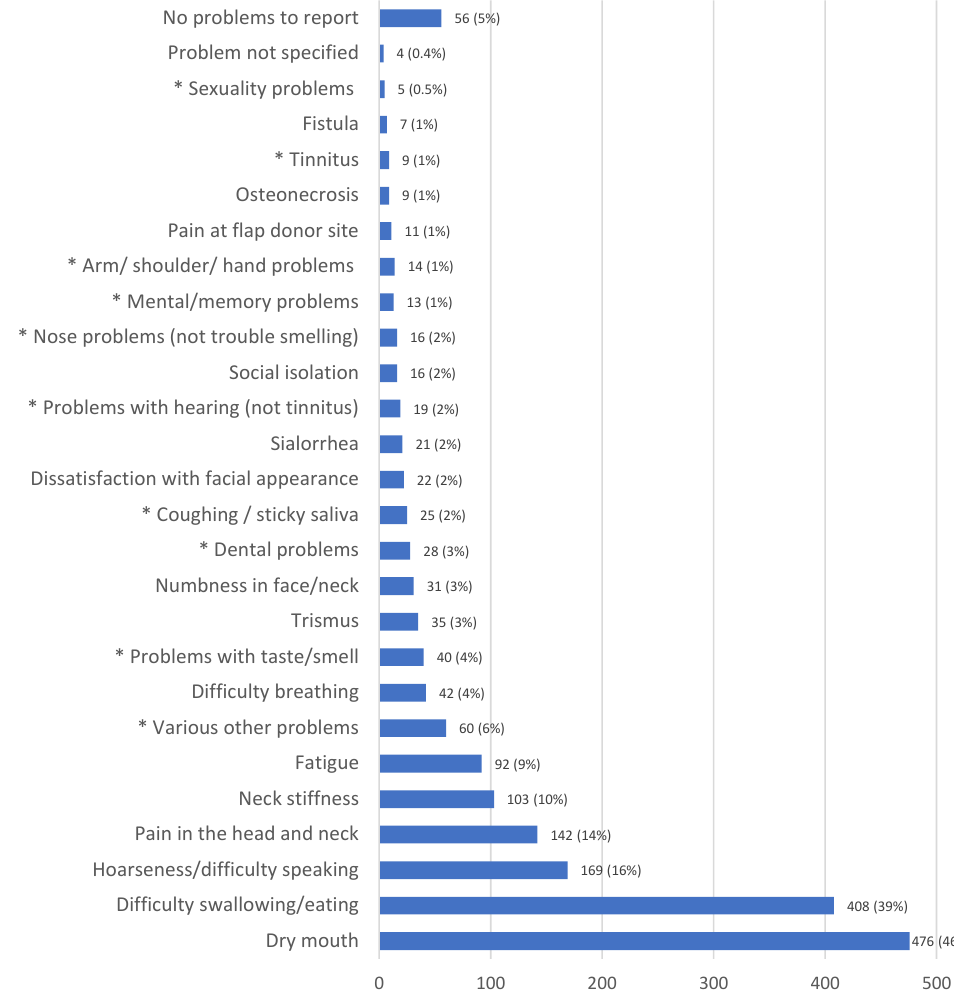
Figure 1. Frequency and percentages of the most serious side effects reported among head and neck cancer survivors. Percentages indicate the proportion of patients who reported the problem. The * symbol indicates a category that resulted from the free text field analysis of the ‘other’ category on the Case Report Form.